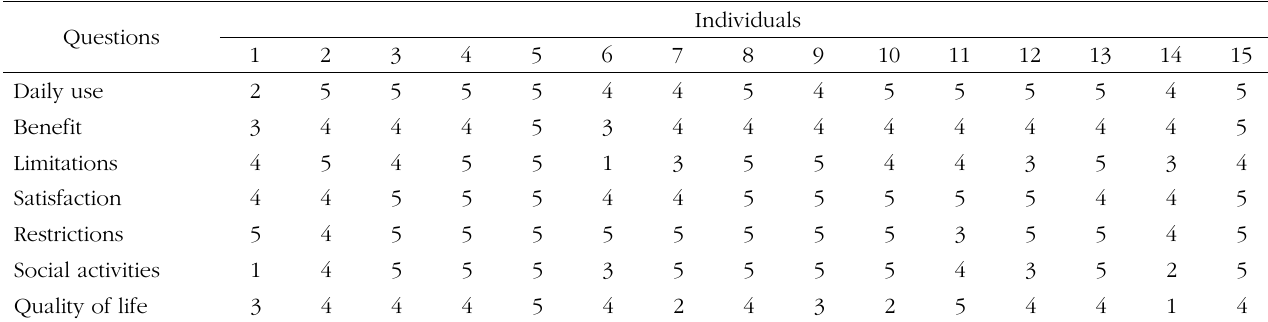
Table 2. Distribution of the answers from each individual concerning the different